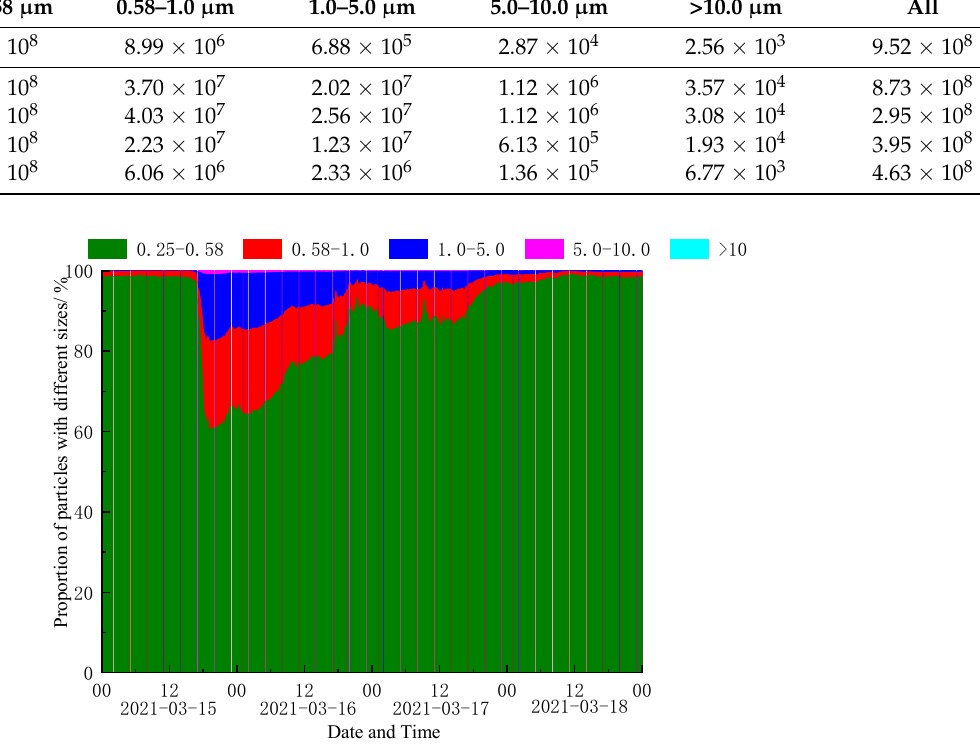
Figure 11. Particle proportion of different size intervals, varying with time.